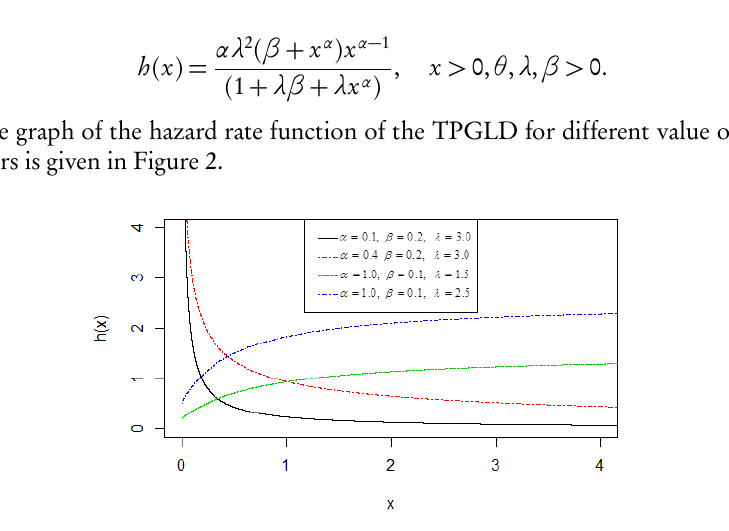
Figure 2 – Hazard rate function of the